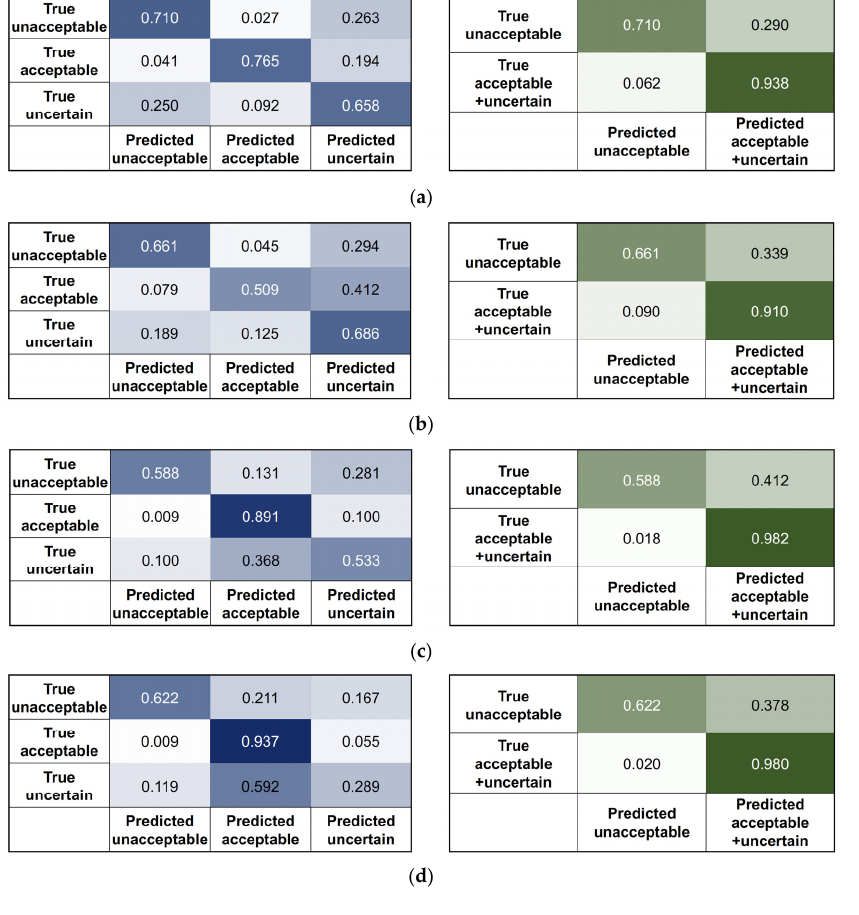
Figure 6. Test results of the one-step approaches on the external data: ( a ) one-step, three-class RF; ( b ) one-step, three-class 2D CNN; ( c ) two-step binary sequential RF approaches; ( d ) two-step binary sequential 2D CNN approaches. The left panels show the 3 × 3 confusion matrices for the original three classes, and the right panels show the 2 × 2 confusion matrices after merging the acceptable and uncertain classes.